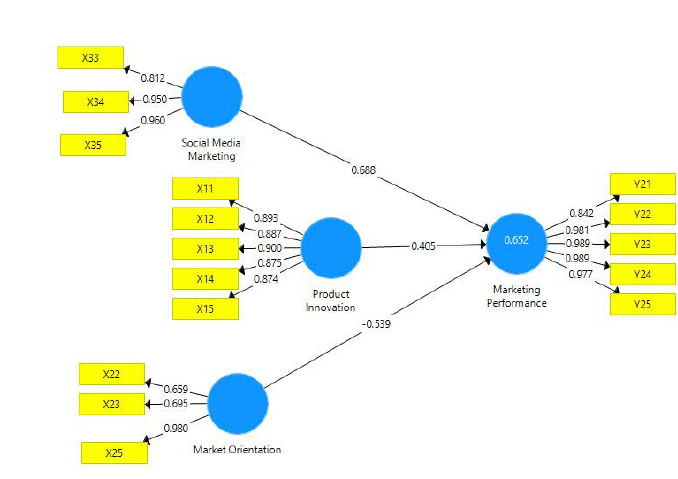
Fig. 2. Convergent Validity